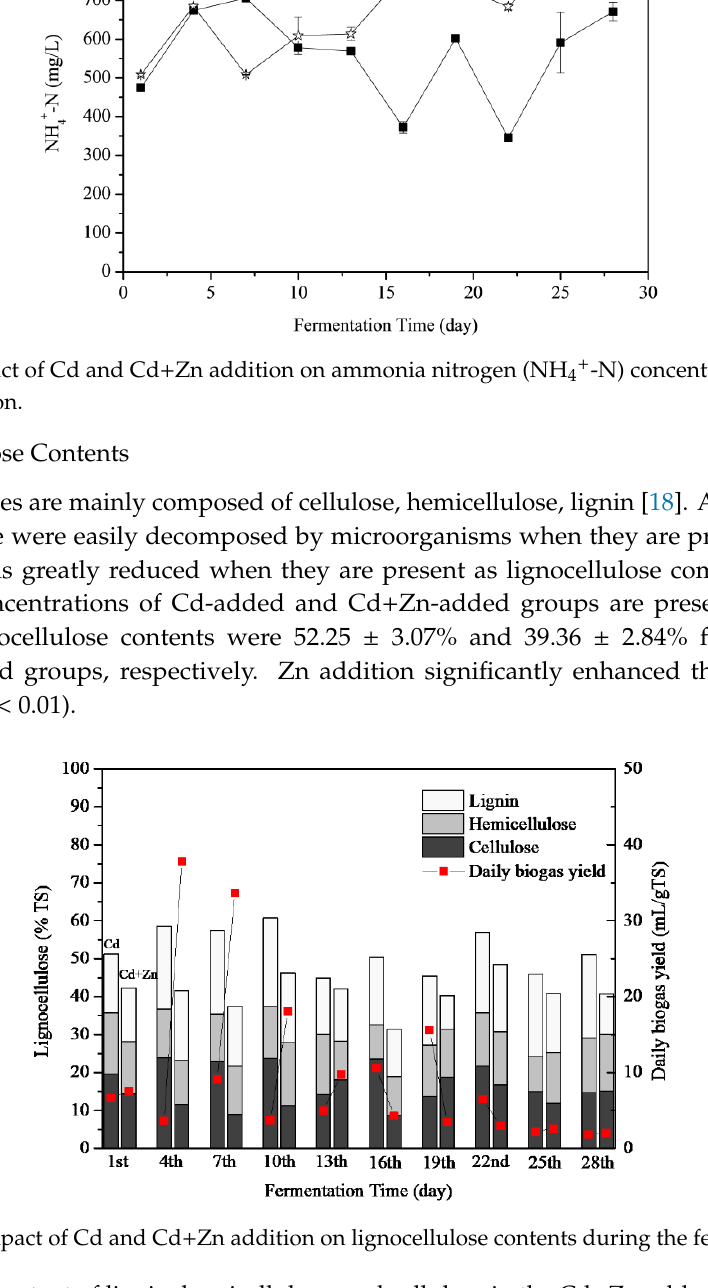
Table 2. Average contents of cellulose, hemicellulose, lignin, and total lignocellulose during the fermentation.